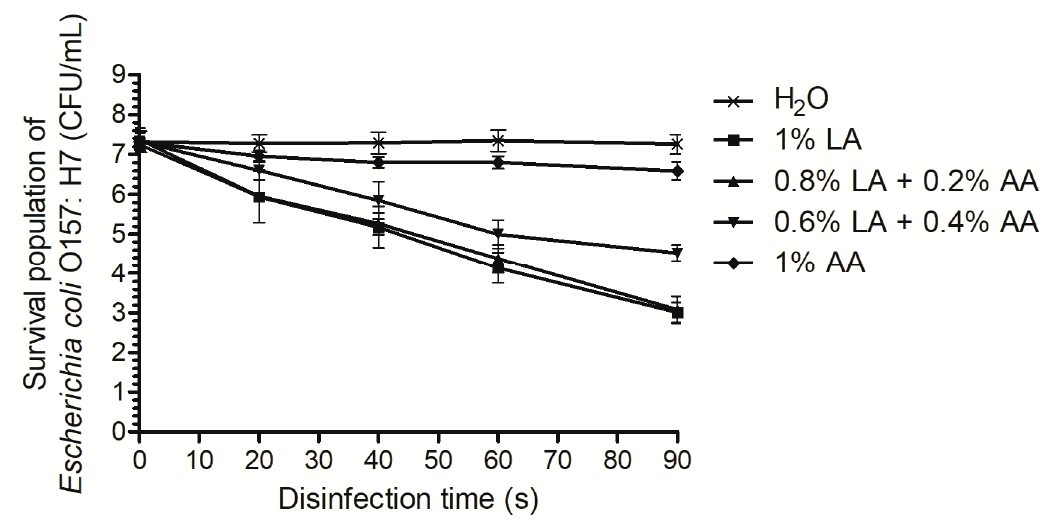
Figure 1. Time-kill curves for different combinations of sanitizers against Escherichia coli O157:H7. AA, acetic acid; LA, lactic acid.